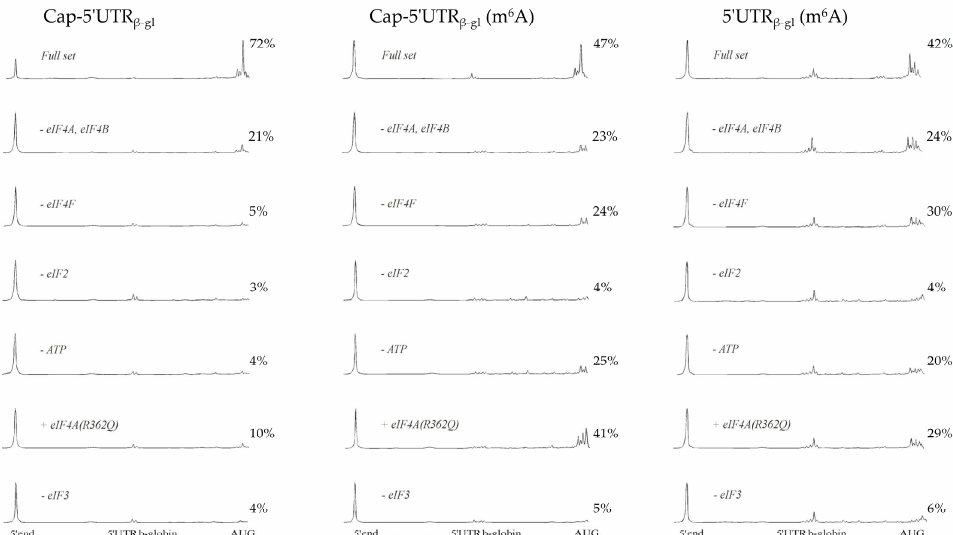
Figure 2. The formation of 48S complexes on mRNAs with the beta-globin leader. Left panel, capped unmodified mRNA (Cap-5 ′ UTR b-gl ); middle panel, capped m 6 A-modified mRNA (Cap-5 ′ UTR b-gl (m 6 A)); right panel, uncapped m 6 A-modified mRNA (5 ′ UTR b-gl (m 6 A)). Capillary electrophoresis electropherograms of mRNA toeprints are presented. The peak on the 5 ′ end corresponds to the full-length reverse-transcription product: the peaks on AUG—to 48S complexes. The calculated specific fluorescence intensity is indicated above each 48S peak (%). Quantification is relative (the proportion between peaks) for each electropherogram.